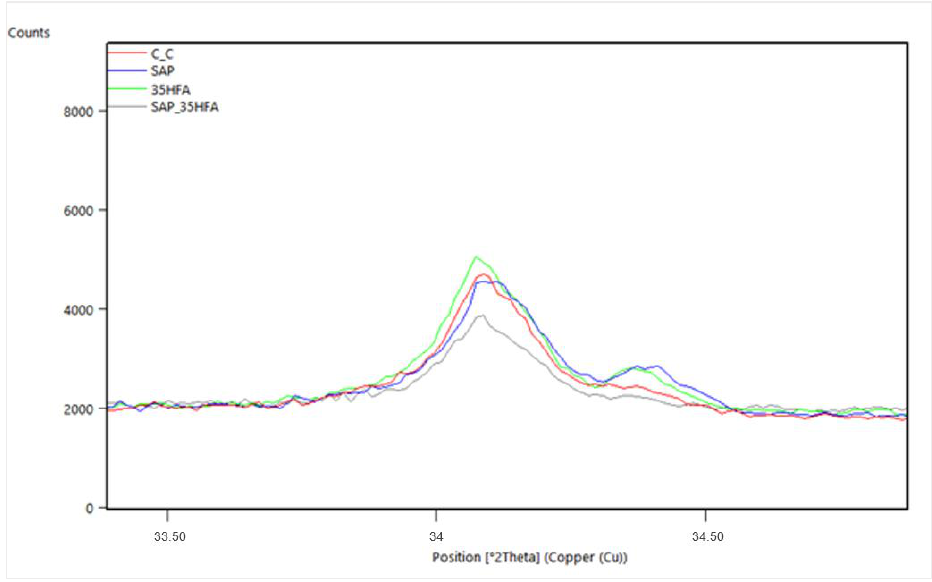
Figure 16. Detail of the most intensive peak of the portlandite at the degree 2 Theta 34.098°.